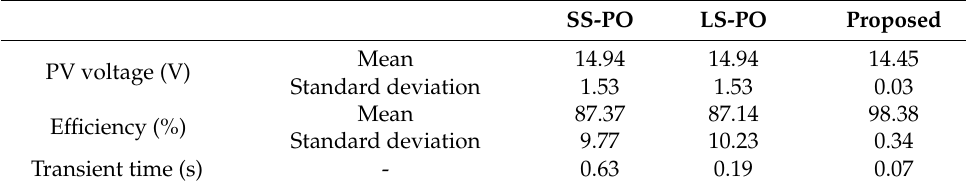
Figure 14. Histogram of PV results: ( a ) PV output voltage and ( b ) system-tracking efficiency. Table 3. Comparison of Output Results Among Various P&O MPPT Algorithms.